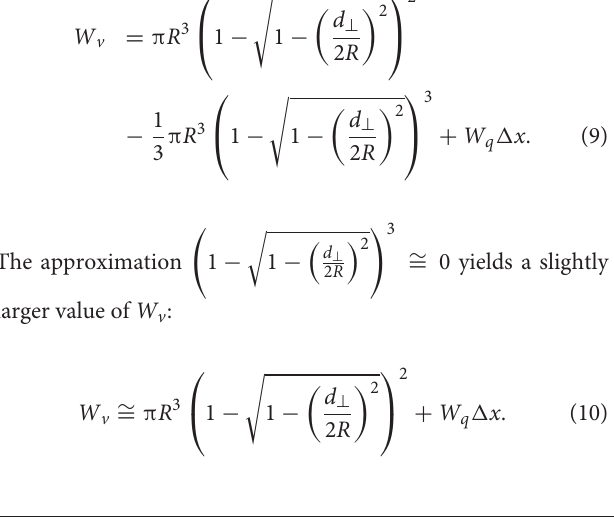
Frontiers in Mechanical Engineering |